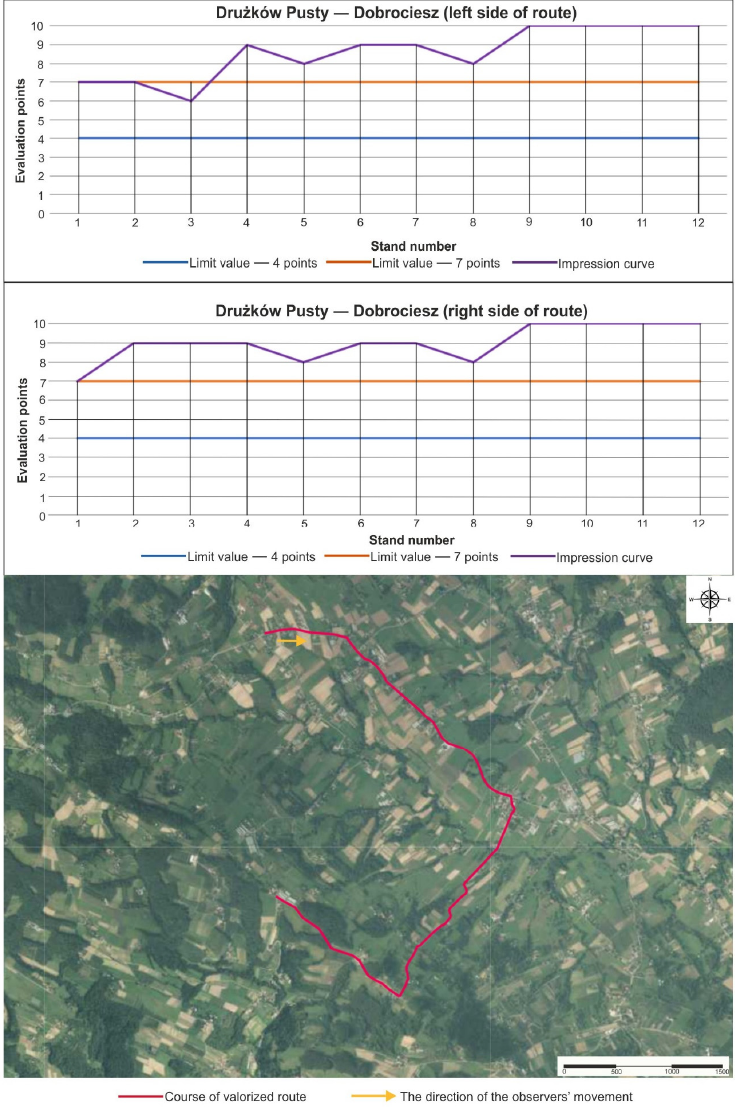
Figure 15. Impression curves for the Dru ż ków Pusty—Dobrociesz route (Iwkowa Commune). Route 4: Dobrociesz—Wojakowa. This section is about 8 km long. The route on both sides was rated the highest, with an average of 9.3 points on the left and 9.1 points on the right. The lowest score received on this section was 8 points (Figure 16). The first part of this area is almost completely devoid of buildings, while the later part is characterized by very sparse buildings. As in Route 3, the focus is on open landscape here. The view